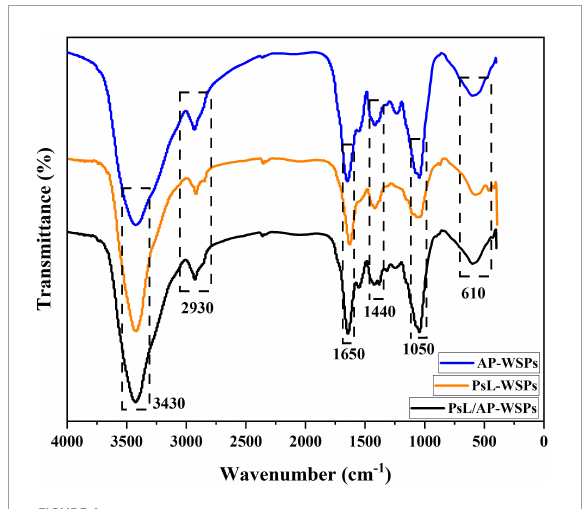
FIGURE4 FTIR characterization of AP-WSPs, PsL-WSPs, and